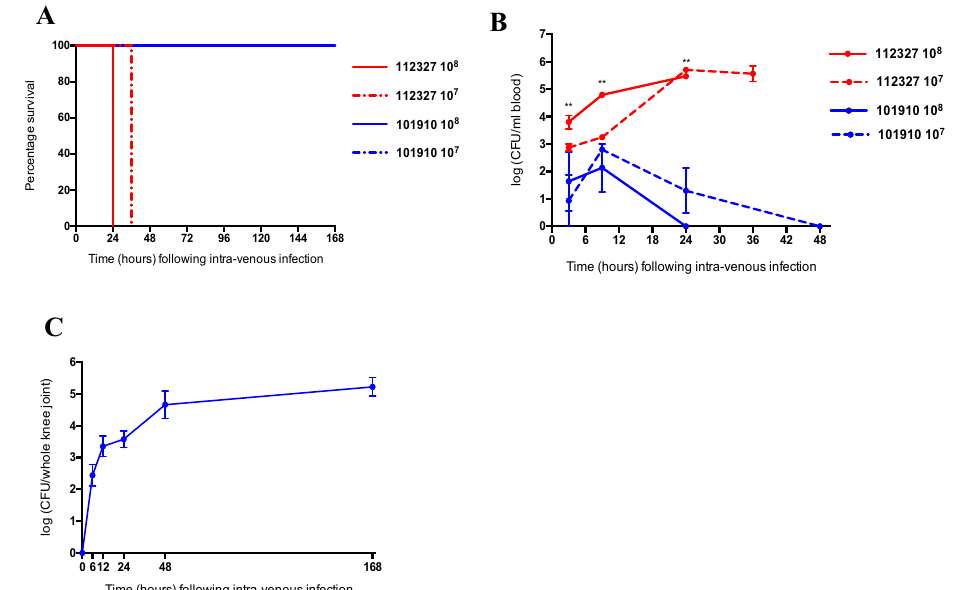
Figure 2. In vivo characterisation of emm type 32.2 (isolate 112,327) and emm type 1.0 (isolate 101,910) in a model of invasive GAS infection. ( A ) Kaplan Meier plots representing percentage survival of CD1 mice (n = 10 per group) following 10 8 and 10 7 CFU intravenous infection with emm type 1.0 (isolate 101,910) and emm type 32.2 (isolate 112,327). ( B ) The bacterial CFU in blood for each isolate and infectious dose over time. ( C ) The bacterial CFU in knee joints of CD1 mice (n = 10, knee joints n = 20) following intravenous infection with 10 7 CFU (50 μl) of emm type 1.0 (isolate 101,910). **p value < 0.01 when analysed using a one-way ANOVA followed by a Kruskall-Wallis multiple comparisons test.